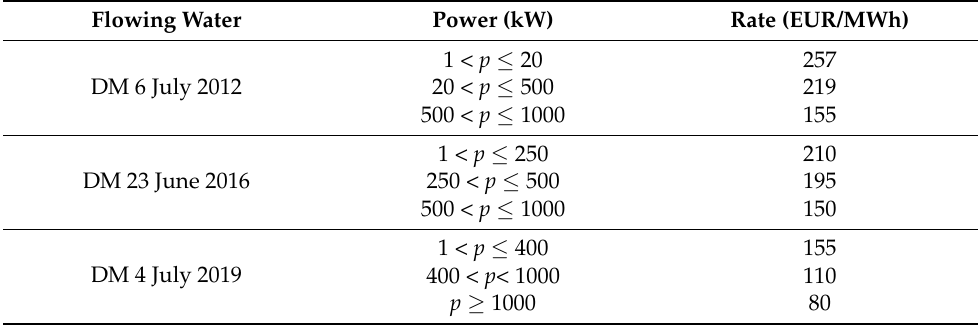
Table 4. Tariff associated with different power for different ministerial decrees [24–26]. Flowing Water Power